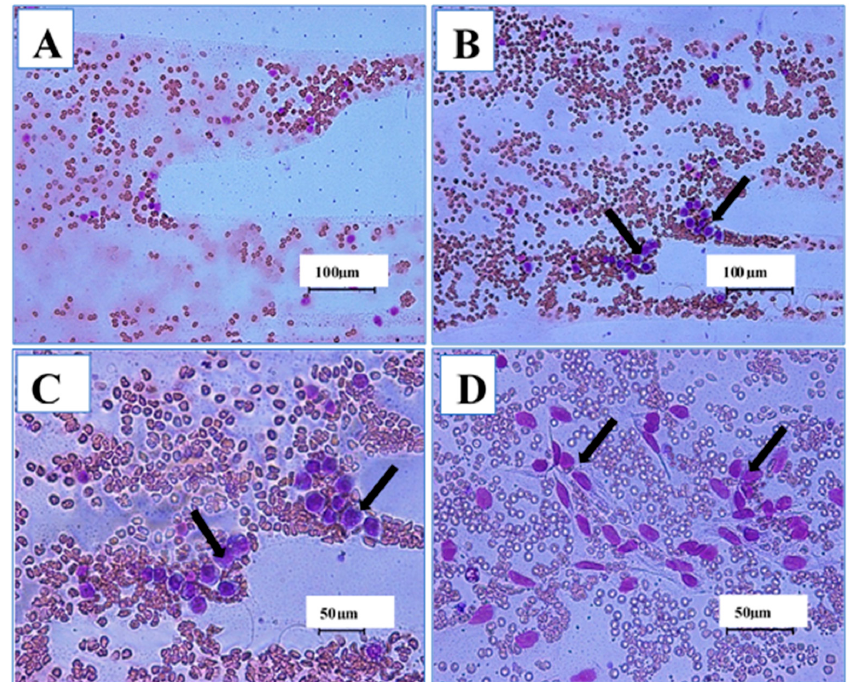
Figure 3. The effects of intraperitoneal (IP) injections of n -ethyl- n -nitrosourea (ENU) on the peripheral blood smears of male ICR-mice. Key: ( A ) Photomicrograph of blood smear (Wright stain ×100) from